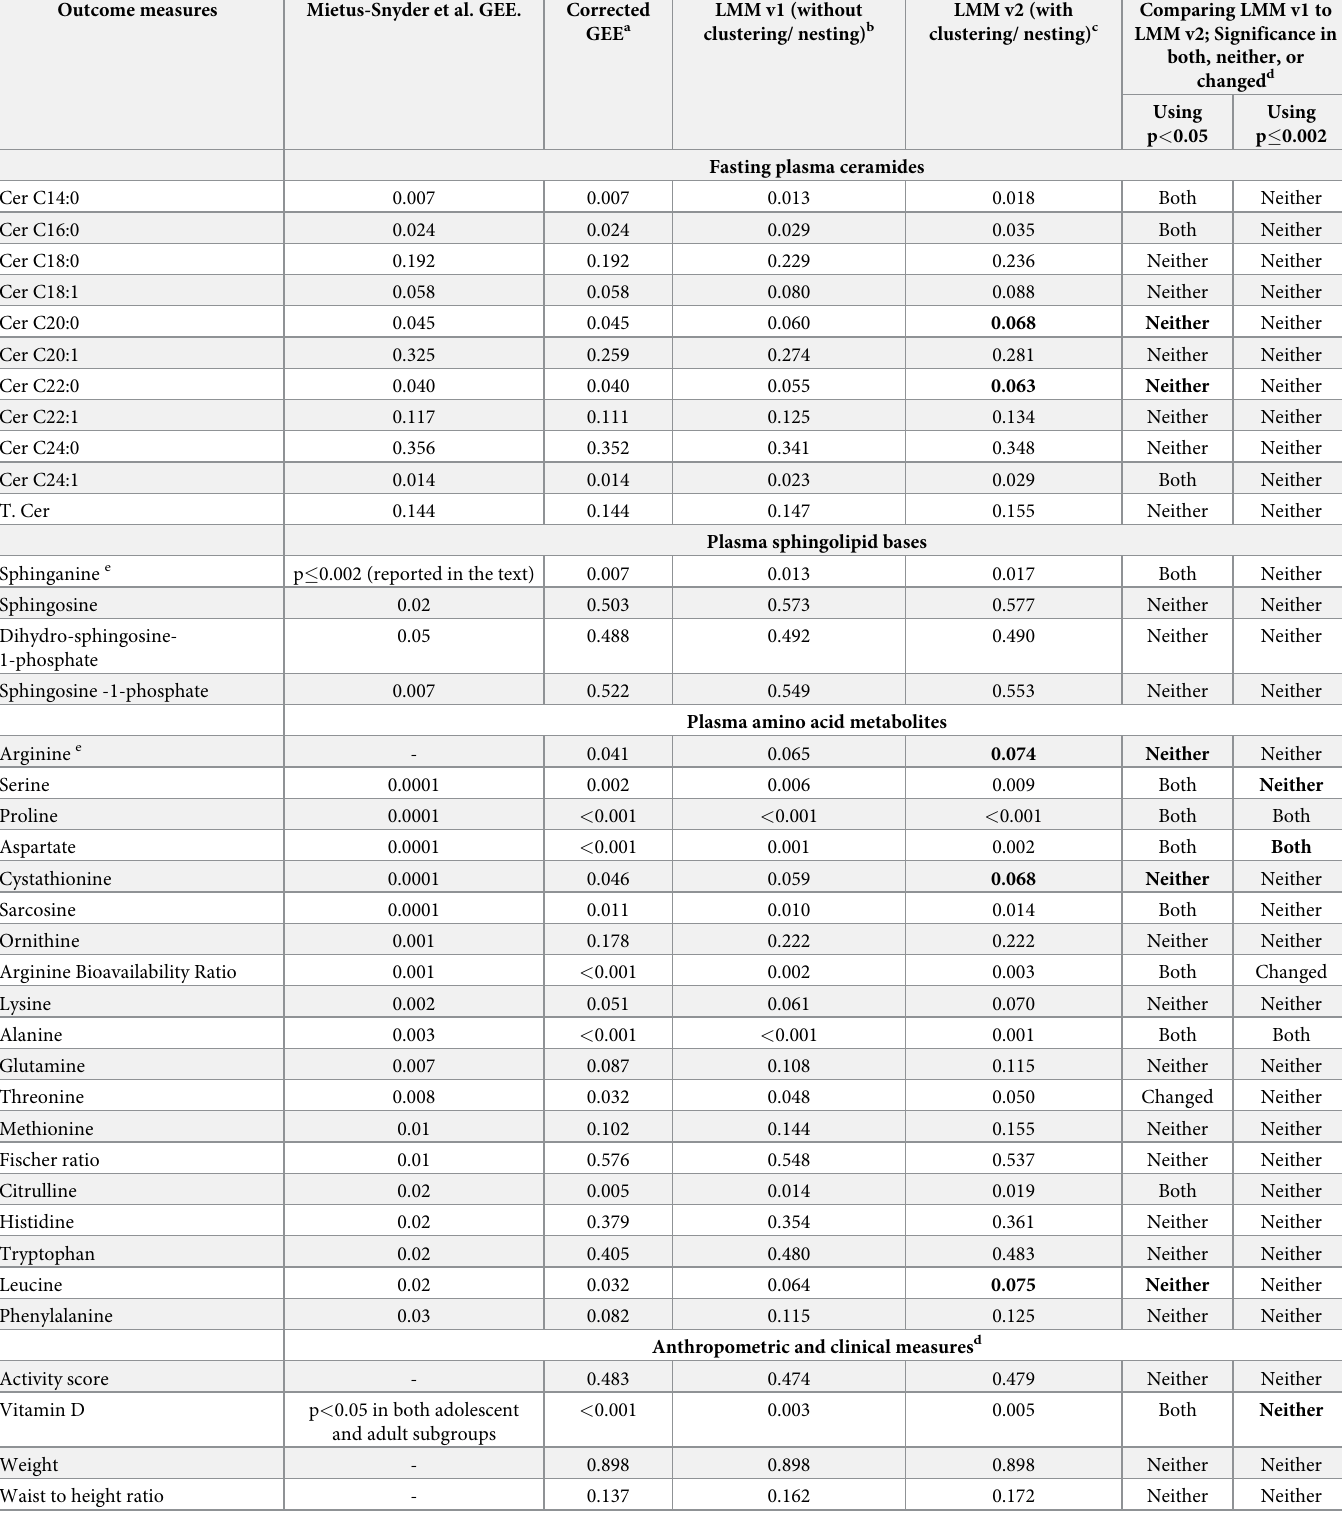
Table 1. Time x group interaction p-values from generalized estimating (GEE) and linear mixed effect models (LMM). Outcome